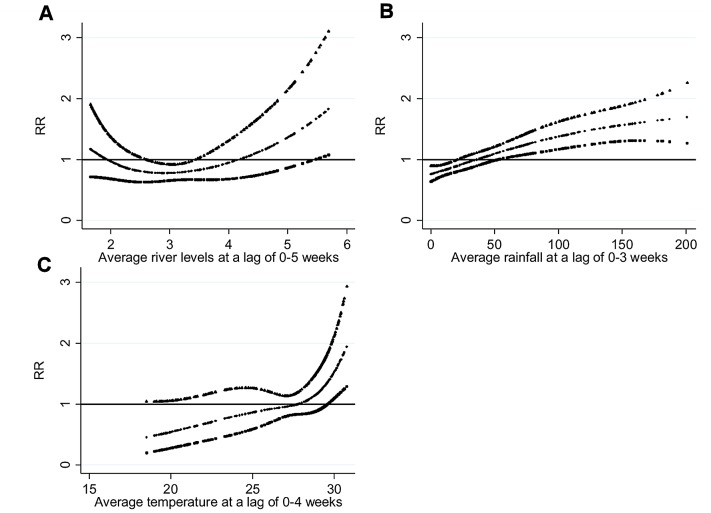
Temporal relationship between the number of typhoid cases and environmental variables.(A) Average river levels over lags of 0–5 weeks, (B) Rainfall over lags of 0–3 weeks and (C) Temperature over lags of 0–4 weeks (shown as a 3 df natural cubic spline) adjusted for seasonal variation, inter-annual variations and public holidays. RR represents the relative risk of typhoid (scaled against the mean weekly number of cases). The centre line in each graph shows the estimated spline curve, and the upper and lower lines represent the 95% confidence limits.